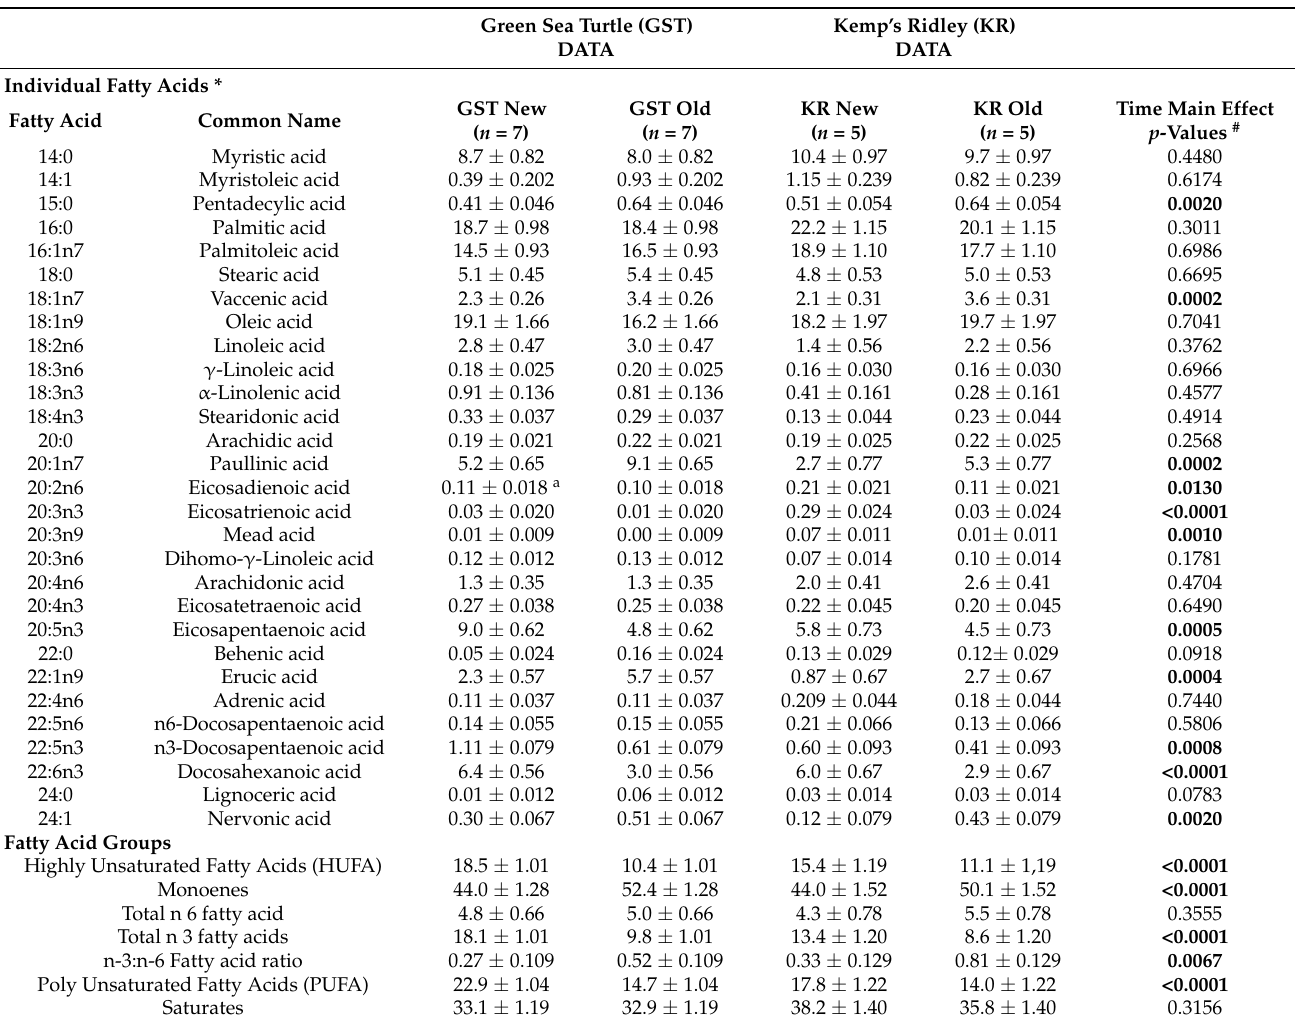
Table 3. Total whole-blood individual and fatty acid grouping profiles (%, mean ± SEM) for juvenile green (GST; Chelonia mydas) and Kemp’s ridley (KR; Lepidochelys kempii ) turtles in rehabilitation housing as analyzed by time, both immediately after sampling (New) and after four years frozen at − 80 ◦ C